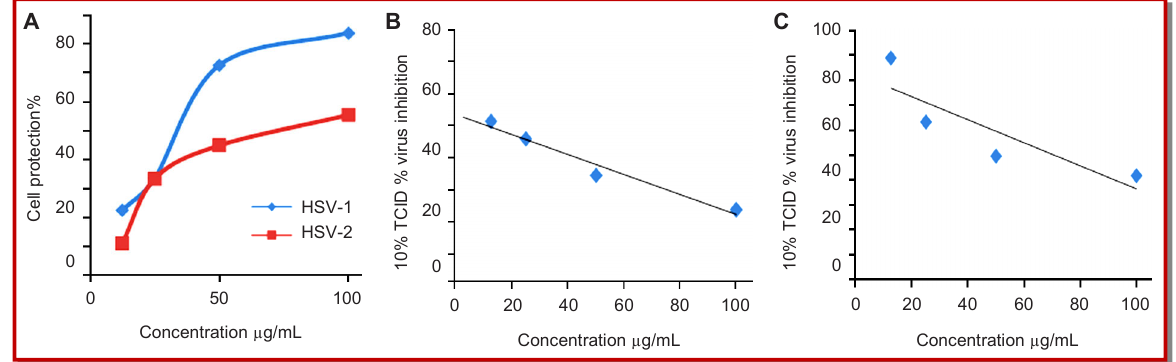
Figure 4: MTT antiviral assay on BanLec and the cell protection against HSV-1 and HSV-2 (A). Antiviral activity of BanLec against HSV-1 (B) and HSV-2 (C) virus at 10 TCID 50 (50% Tissue culture infectivity dose). The EC 50 was calculated using regression line. Data’s were expressed as mean ± SD from three independent (Figure 3). All four concentrations of BanLec revealed varying degrees of inhibitory effect against the HSV-2 with various cell protection. In the cytopathic effect inhibition assay, the BanLec showed less protection against the HSV-2 virus challenge dose of 10 TCID 50. According to MTT assay, the inhibition percentage gra- dually decreases with an increase in the concentration of BanLec to reach 55.6%, 45.1%, 33.6% and 11.2% of cell protection of virus growth (Figure 4). As for antiviral assay, 44.4% and 55.0% inhibition were observed when the concentration of BanLec was at 100 µg/mL and 50 µg/mL respectively for HSV-2 and 66.5% and 88.9% inhibition was observed at 25 µg/mL and 12.5 µg/mL. The 50% effective concentration (EC 50 ) obtained was comparatively low as 67.7 ± 2.4 with inhibitory concentration IC 50 of 172.7 µg/mL (Figure 4). The selectivity index (SI), calculated from the ratio IC 50 /EC 50 was 2.6 µg/mL suggesting moderate to no activity of lectin on HSV- 2 (Table III).